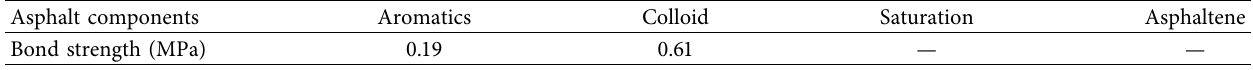
Table 10: Test results of bond strength between asphalt components and stone substrates.